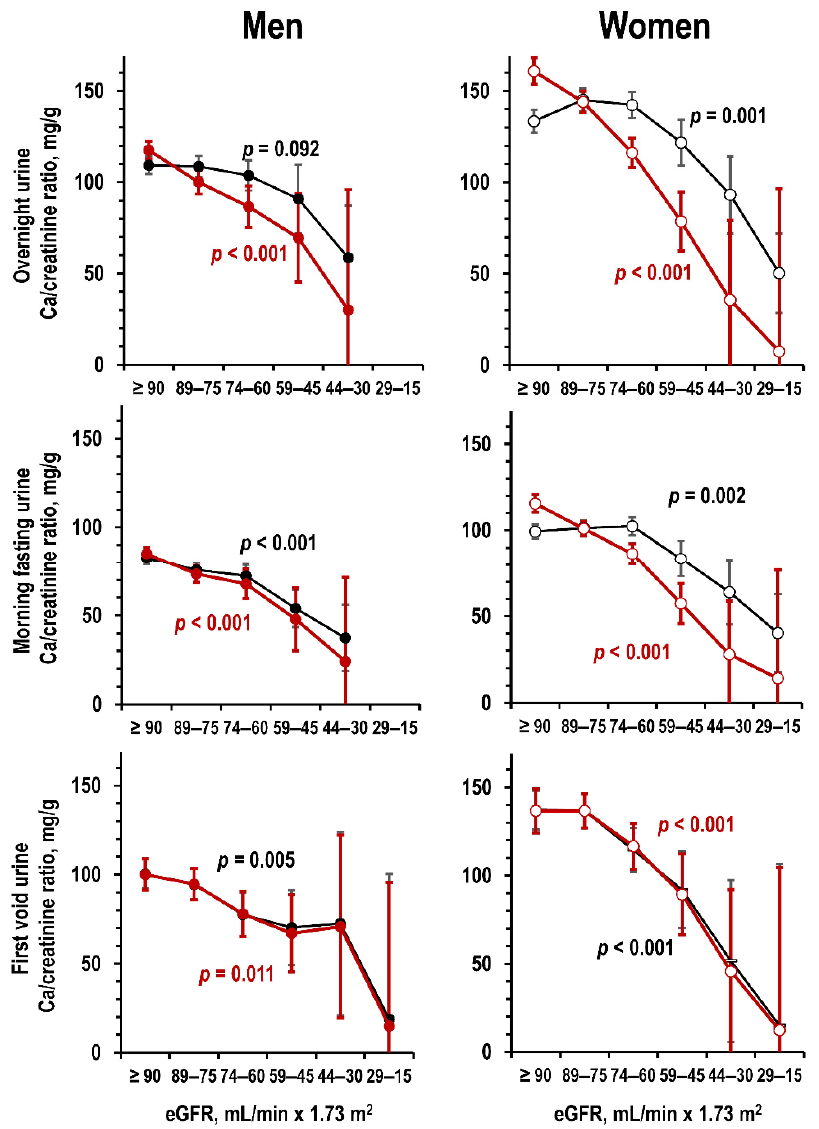
Figure 1. Mean and 95%CI of Ca / creatinine ratio in men and women ( left panels and right panels, respectively) by eGFR stratum in overnight urine ( upper panels, Gubbio study dataset), in morning fasting urine ( central panels, Gubbio study dataset), and in first-void morning urine ( lower panels, Moli-sani study dataset) in uni-variate ANOVA and in ANOVA controlled for age and weight (black line and red line, respectively). Number of individuals per eGFR stratum from left to right: Gubbio study dataset, men = 905, 451, 164, 31, 4, and 0—women = 680, 677, 471, 109, 13, and 3; Moli-sani study dataset, men = 195, 168, 88, 30, 5, and 2—women = 139, 175, 107, 36, 8, and 2. No individual had eGFR < 15 mL / min × 1.73 m 2 .